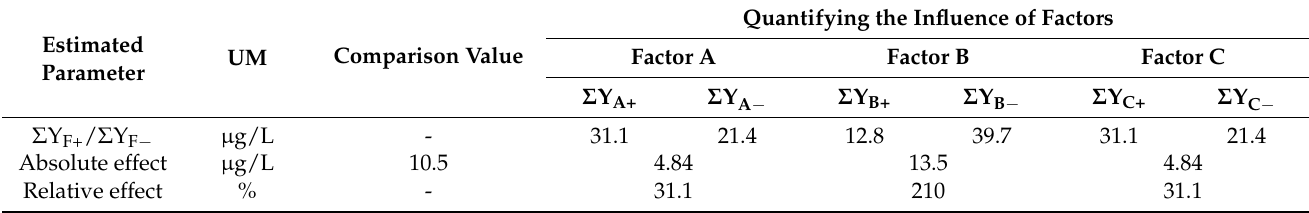
Table 8. Quantification of the variability of the operating parameters of the Hg 2+ determination procedure using DPV technique with SPE-poly L modified electrodes, Test 2.